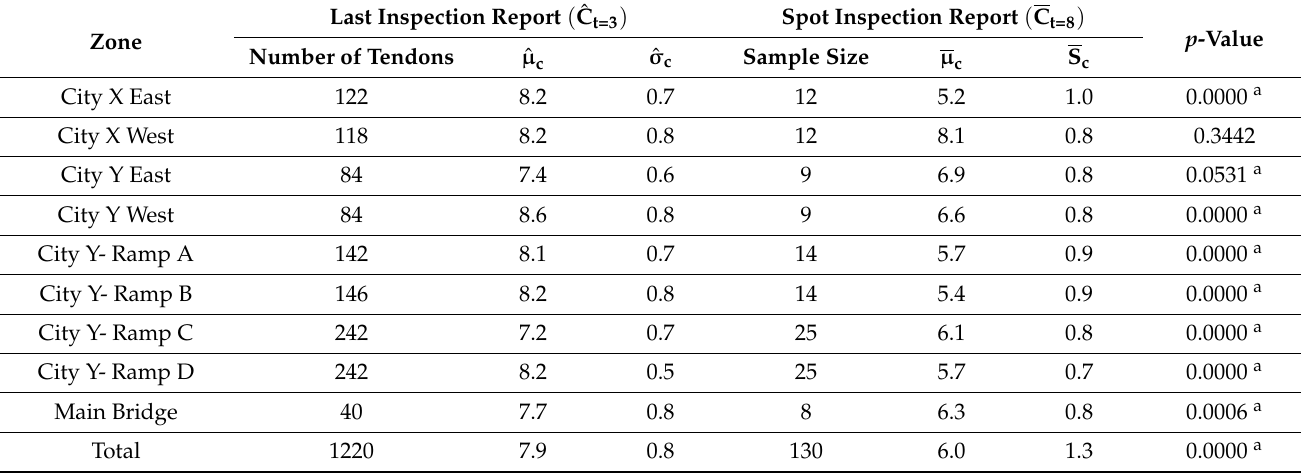
Table 4. SNBI rating statistics in different zones of the bridge in the case study.